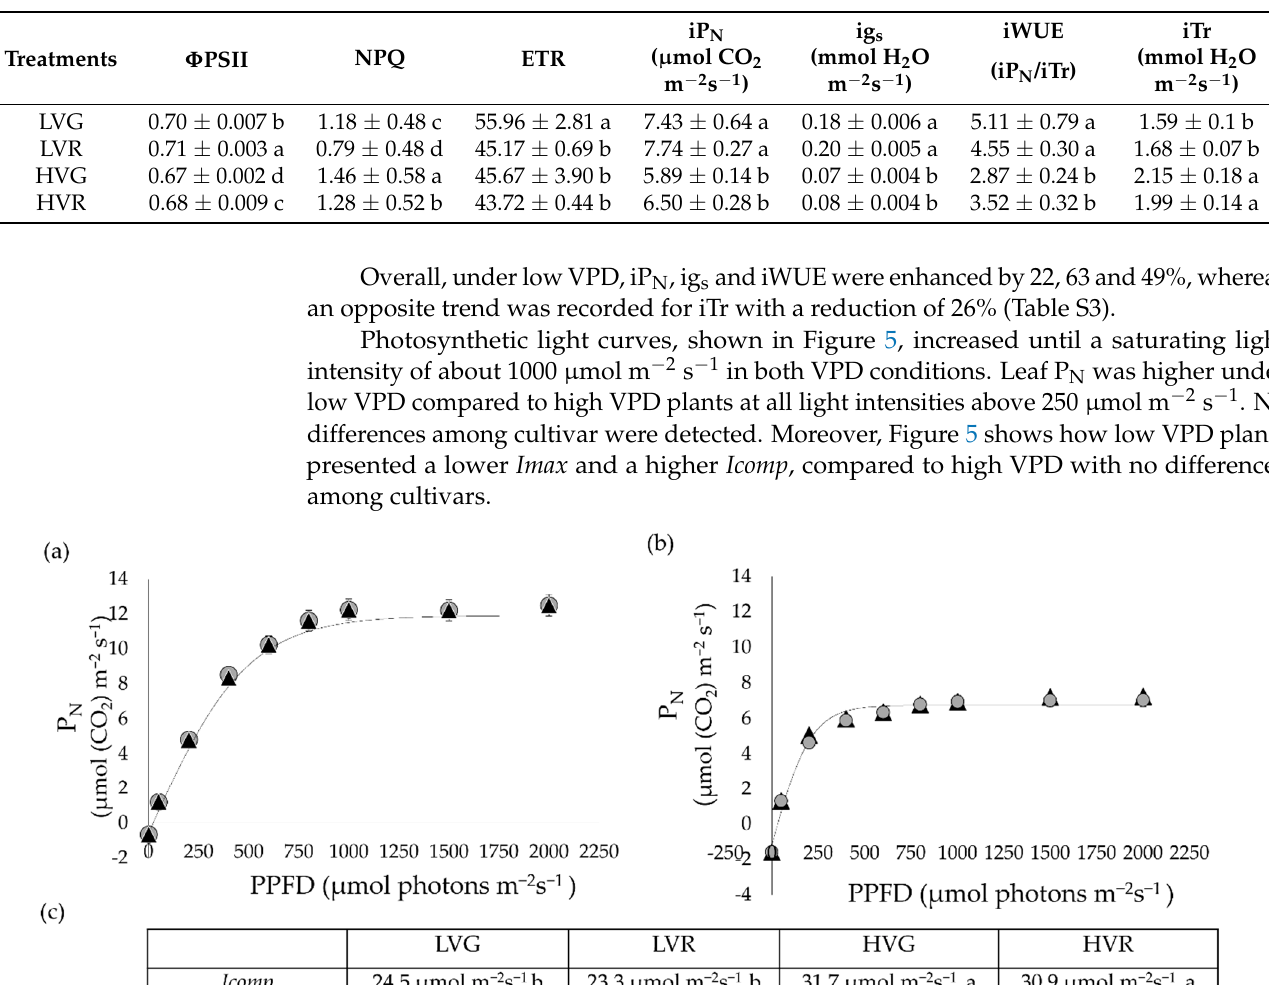
Table 2. Effect of VPD (LV and HV) on physiological parameters of green (G) and red (R) plants. Quantum yield of PSII ( Φ PSII), nonphotochemical quenching (NPQ), electron transport rate (ETR) for instantaneous values of gas exchange. Net photosynthesis (iP N ), stomatal conductance (igs), transpiration (iTr), water use efficiency (iWUE). Mean values (n = 9) ± standard errors are shown. Different letters correspond to significantly different values among treatments within a given date, according to Tukey’s HSD ( p ≤ 0.05).